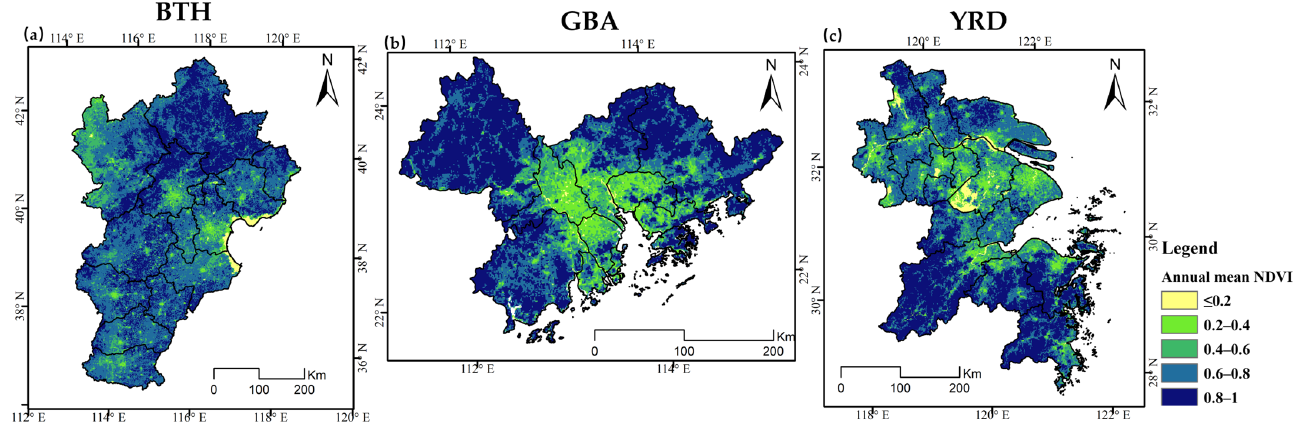
Figure 10. Spatial stratification of the biological health situations in the three UAs: ( a ) BTH, ( b ) GBA, and ( c ) YRD. and ( c )